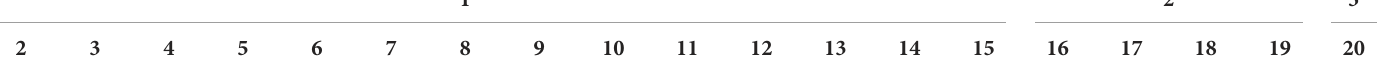
TABLE 3 Similarity of the B. bigemina rap-1a gene sequences as detected in cattle samples in Thailand and other countries. Clade Accesion